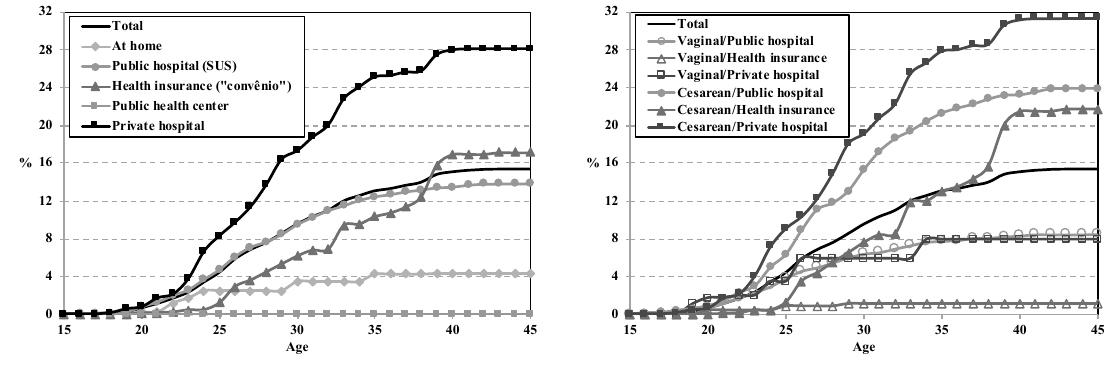
Figure 1. Cumulative percentage distribution of sterilized women by age at the moment of sterilization, Brazil, January 2001 to July 2007. Note: Parity at delivery, type of delivery, and place of delivery relate to information from the last birth. Source: 2006 Brazilian National Survey on Demography and Health of Women and Children (PNDS).